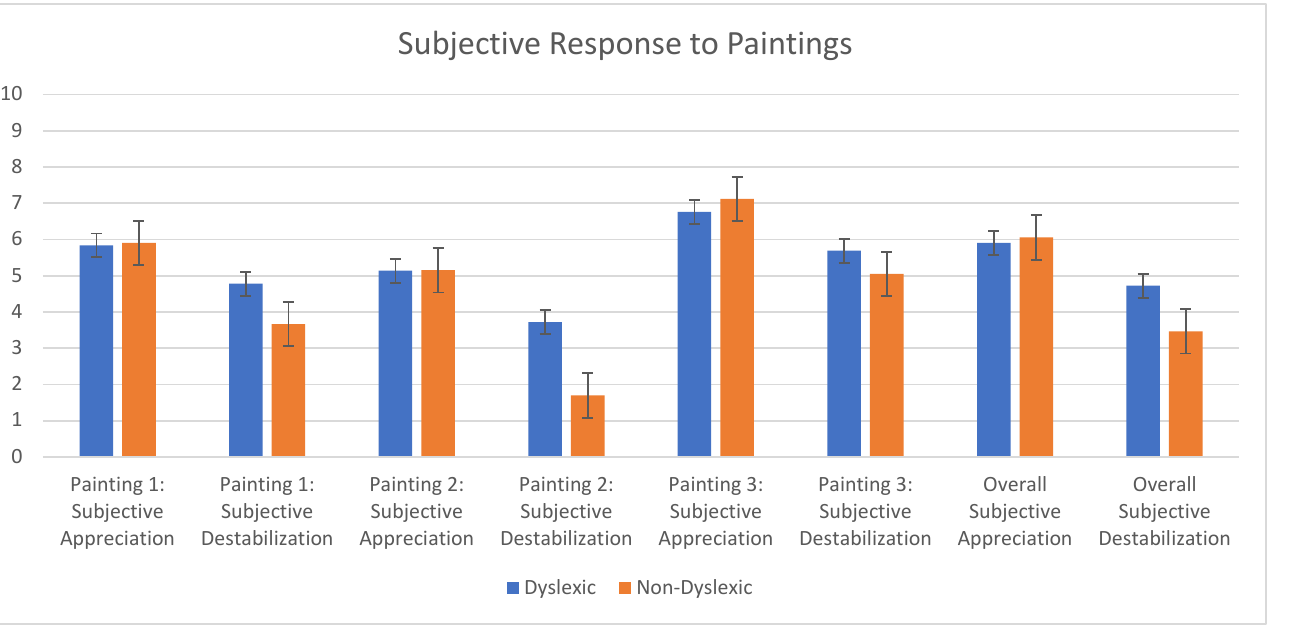
Figure 4. Subjective feelings of appreciation and destabilization after viewing each painting in the dyslexic and non-dyslexic populations.